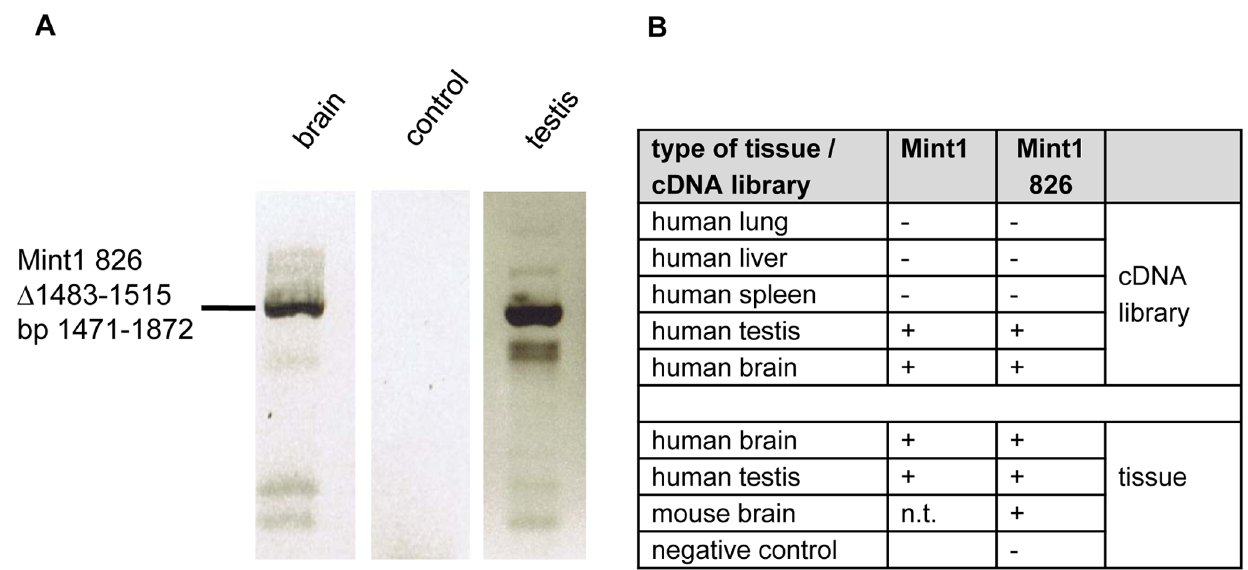
Figure 4. Detection of Mint1 826 mRNA. Various types of cDNA libraries derived from lung, liver, spleen, testis and brain were analyzed for the existence of Mint1 826. For this purpose a Mint1 826 specific primer that does not amplify the conventional Mint1 (tested using a linearized pACT Mint1 vector as a template, negative control) was applied in PCR analyses containing the libraries as templates. Positive results were confirmed utilizing mRNA isolated from the respective tissues. Additionally, the respective samples were also tested for the existence of the conventional Mint1 mRNA. A) Mint1 826-specific PCR analyses using RNA from human brain and human testis tissues. B) Summary of the Mint1/Mint1 826-specific PCR analyses.